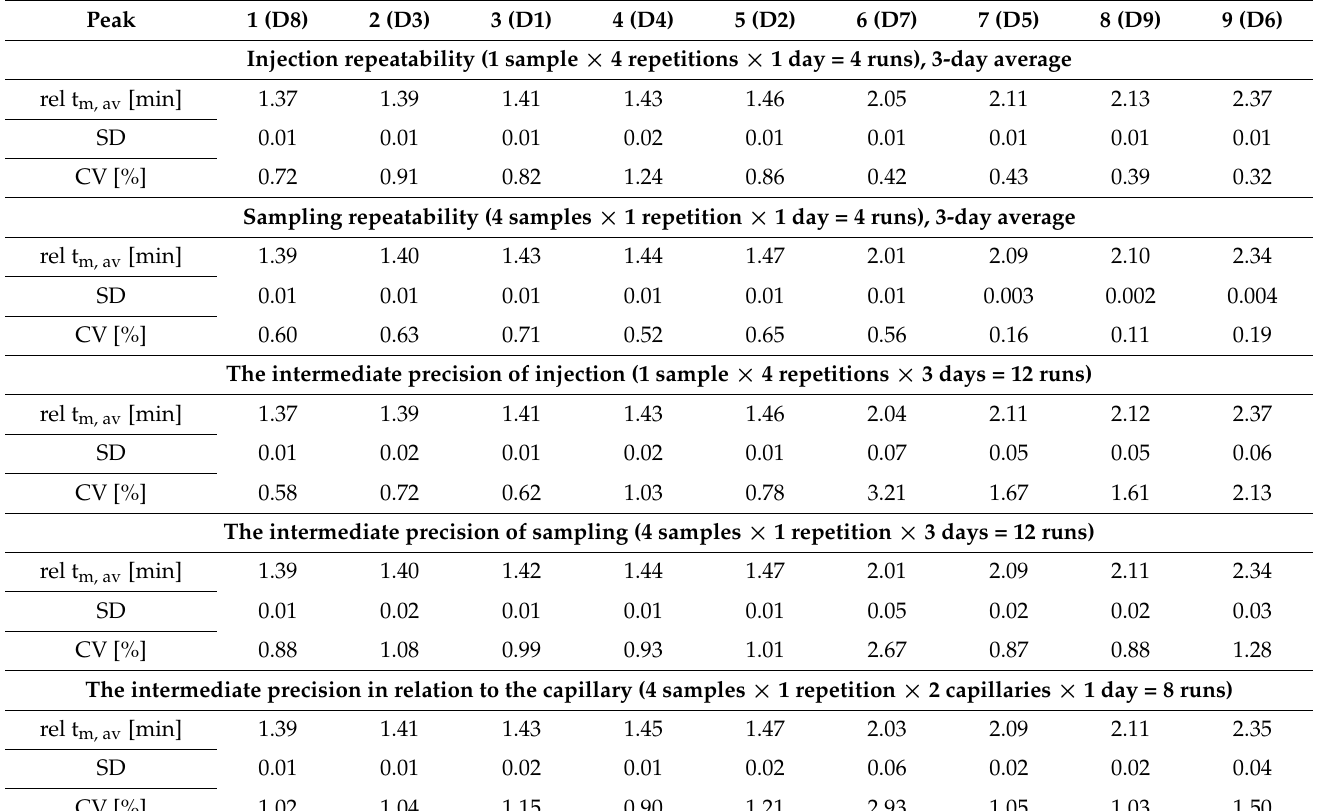
Table 2. The results of validation—average relative migration times, standard deviation (SD), and coefficient of variation (CV) of 9 peaks corresponding to standard disperse